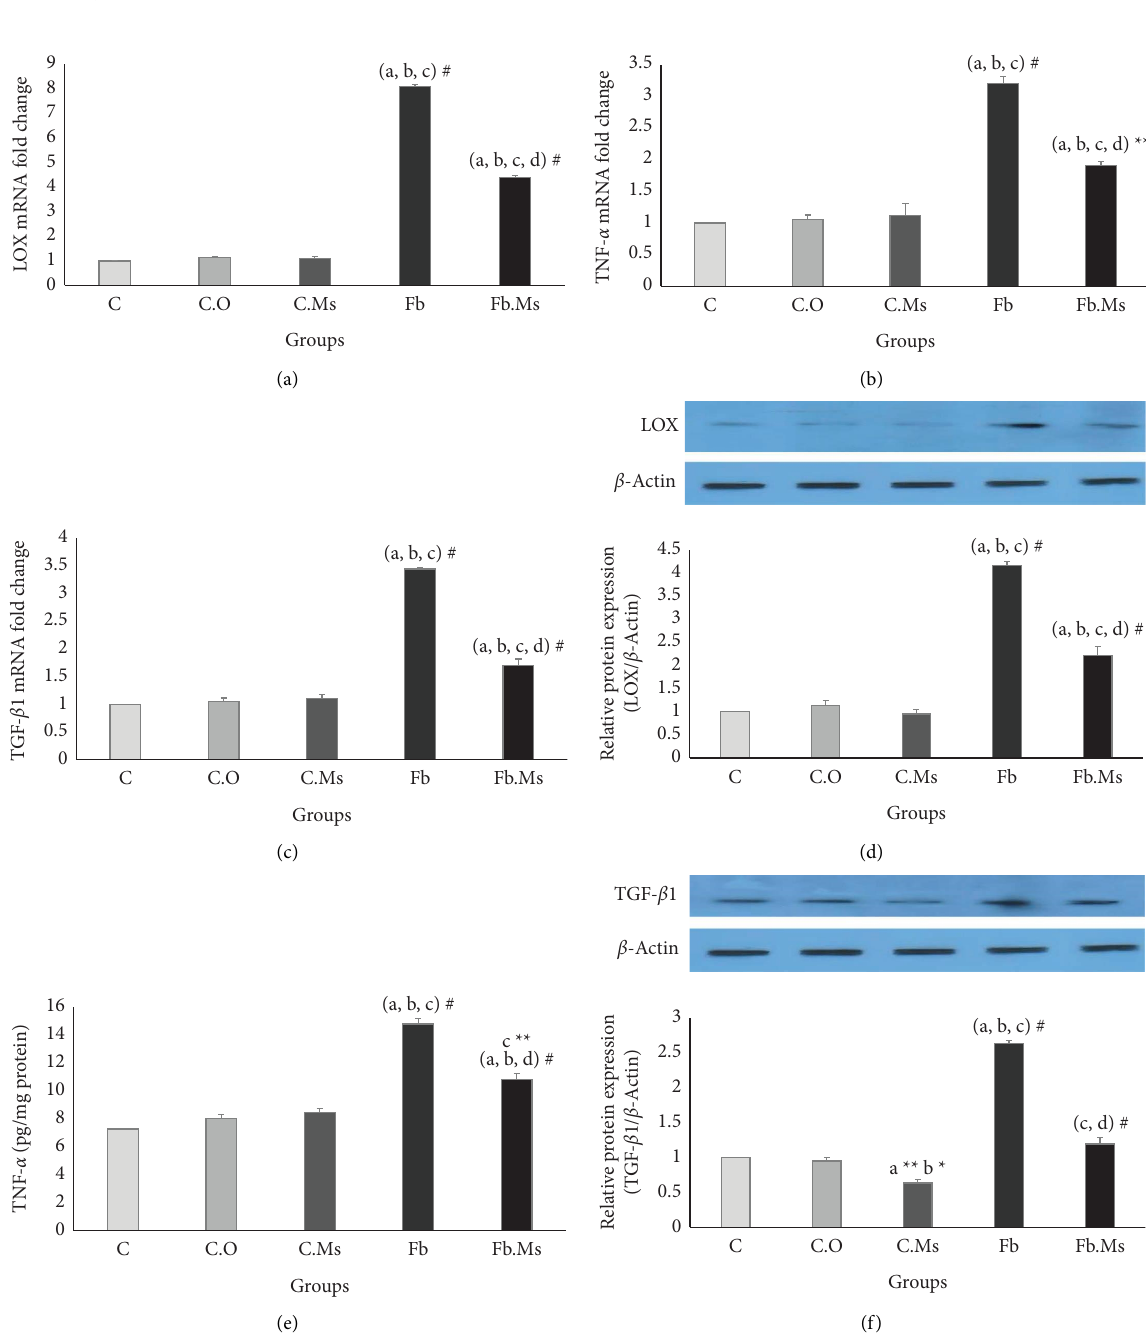
Figure 4: Te results of the protein and gene expressions of LOX, TNF- α , and TGF- β 1 in the lung tissue of studied animals. (a) Level expressions of lysyl oxidase (LOX) gene, (b) level expressions of tumor necrosis factor-alpha (TNF- α ) gene, (c) level expressions of transforming growth factor- β 1 (TGF- β 1) gene. (d) Level expressions of LOX protein. (e) Level expressions of TNF- α protein, (f) level expressions of TGF- β 1 protein. C: control group; C.O: olive oil control group. C.Ms: hMSC-CM control group, Fb: fbrosis group, Fb.Ms: group Fb with hMSC-CM treatment. ( ∗ p < 0 . 05, ∗∗ p < 0 . 01, # p < 0 . 001). a Signifcantly diferent from C. b Signifcantly diferent from C.O. c Signifcantly diferent from C.Ms. d Signifcantly diferent from that of